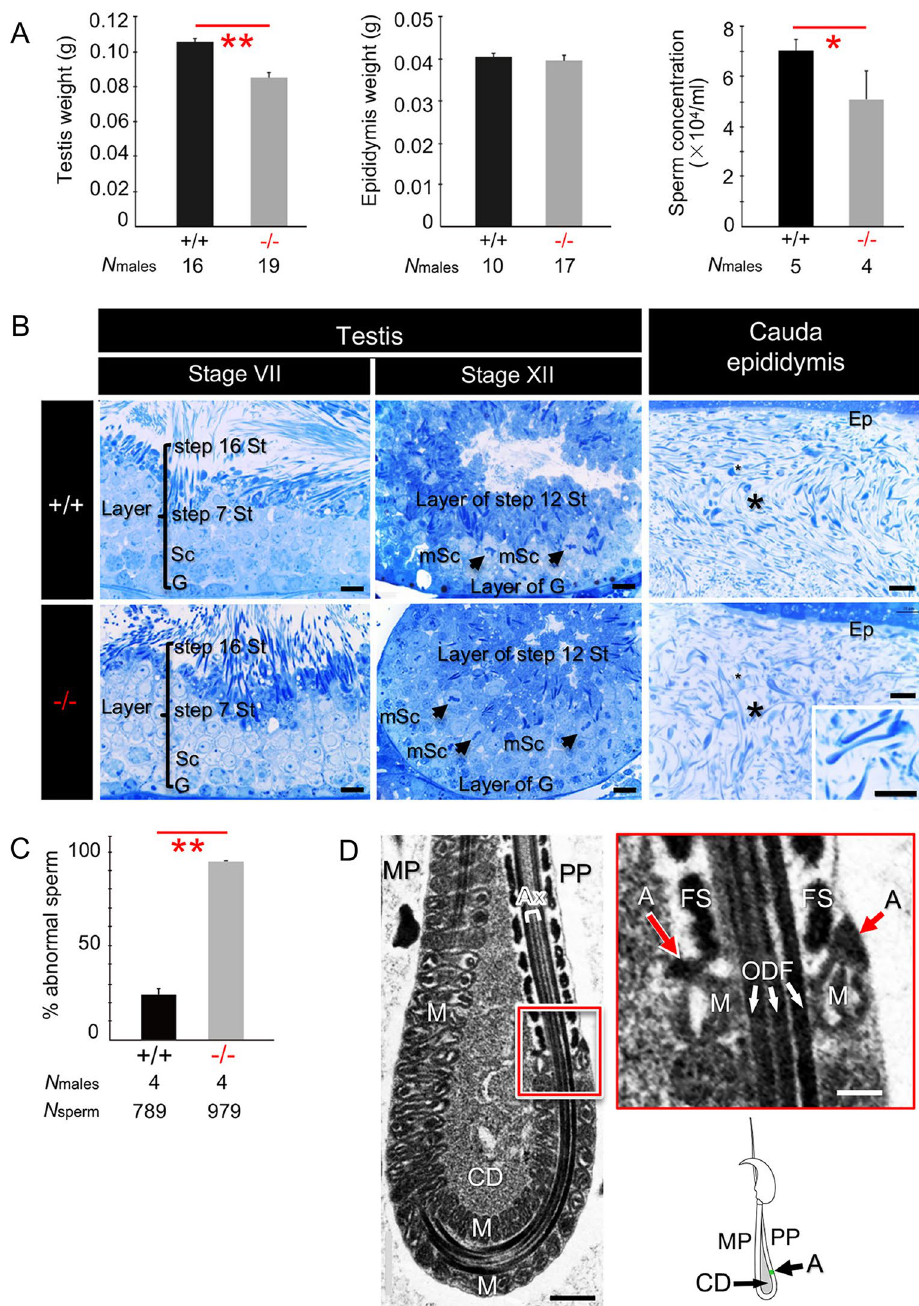
Figure 3. Characterization of Odf4 −/− males. + / + : Odf4 +/+ . −/−: Odf4 −/− . ( A ) Reproductive organs. (Left) Testis weight (g): 0.11 ± 0.00 (+ / +) versus 0.09 ± 0.00 (−/−). Student’s t test (two-tailed analysis). (Middle) Epididymis weight (g): 0.04 ± 0.00 (+ / +) versus 0.04 ± 0.00 (−/−). (Right) Sperm concentration (× 10 4 /mL): 7.1 ± 0.5 (+ / +) versus 5.1 ± 1.2 (−/−). Mann ‒ Whitney U test (two-tailed analysis). ( B ) Spermatogenesis (testis) and spermatozoa in the cauda epididymal lumen (cauda epididymis). Toluidine blue-stained light micrographs. (Left and Middle) Normal spermatogenesis, where developing spermatogenic cells and layers at stages VII (Left) and XII (Middle) are observed. (Right) The cauda epididymal lumen contains a large number of spermatozoa (*) in both Odf4 +/+ and Odf4 −/− mice. (Inset) in Odf4 −/− ; hairpin flagella are observed. Ep: Epithelia. G: Spermatogonia. Sc: Spermatocytes. mSc: spermatocytes during meiosis. St: Spermatids. N = 3 different males. Scale bar = 20 μm for stages VII and XII and 10 μm for the cauda epididymis. ( C ) Percent (%) abnormal spermatozoa. 24.2 ± 3.1 (+ / +) versus 94.5 ± 0.3 (−/−). Welch’s t test (two-tailed analysis). ( D ) TEM showing normal organization of flagellar internal components in Odf4 −/− flagella. (Left) Presence of a cytoplasmic droplet (CD) shown by longitudinal section of the hairpin region. (Top, Right) High magnification of the rectangular area of the left image, with a schematic drawing of hairpin flagellum (Bottom). A Annulus, Ax Axial filaments (not clearly found at this magnification). FS Fibrous sheath, M Mitochondria, MP Midpiece, ODF Outer dense fibers, PP Principal piece. *P < 0.05. **P < 0.01. Scale bar = 0.5 μm, 100 nm for inset (red line,